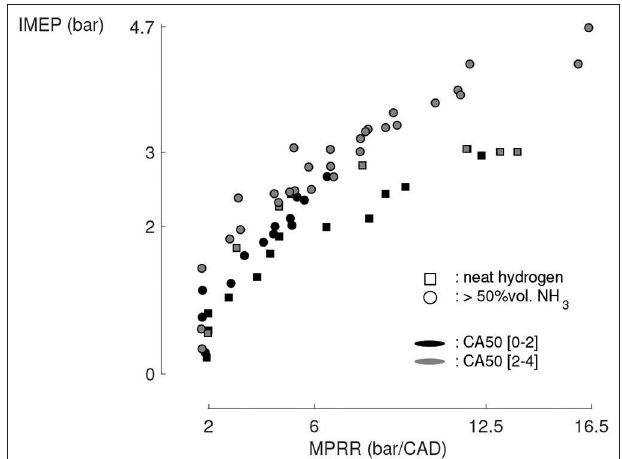
FIGURE 5 | IMEP evolution as a function of the ammonia fraction in the fuel blend (all experimental points, CA50 timings between − 3 and 6 CAD). Ammonia achieves 67% jump in gross IMEP compared to hydrogen. The IMEP only increases after 15%vol. in ammonia fraction, but tapers off after 50%vol. ammonia. The increased IMEP is characterized by a higher equivalence ratio achieved for identical CA50 timings.